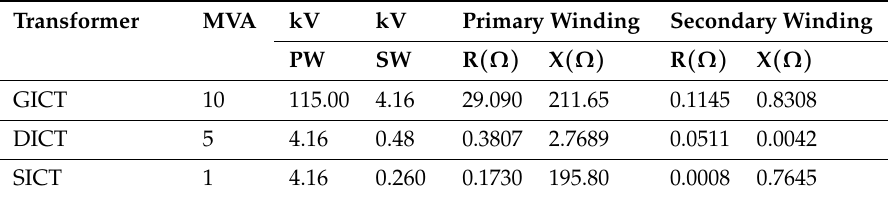
Figure 2. Utility grid interfaced with solar PV plant. Table 1. Interconnecting Transformers of Test System.